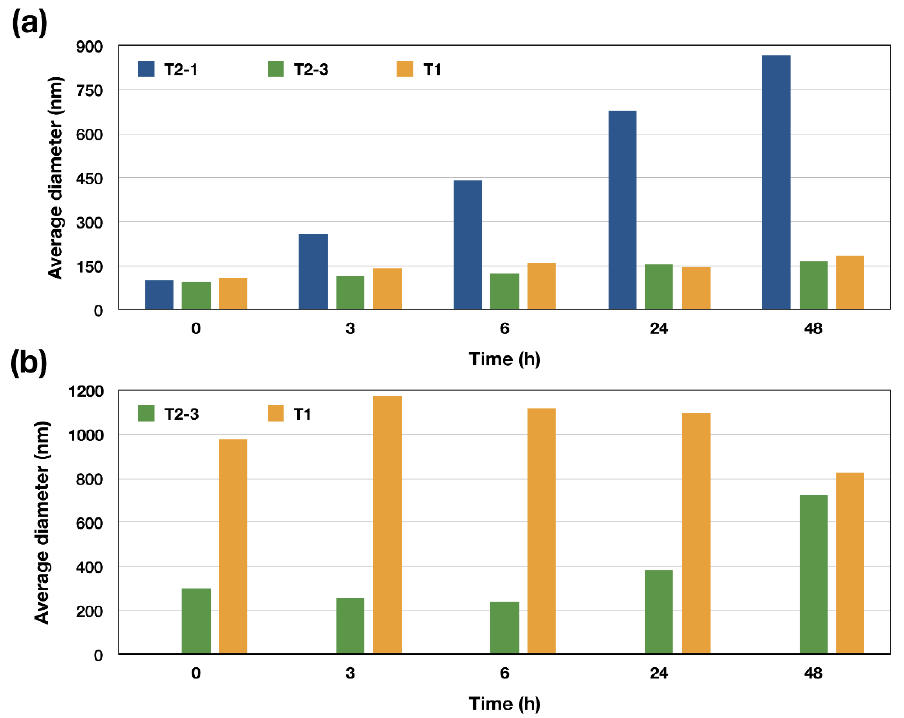
Figure 7. Stability of different triblock copolymer micelles assessed by DLS measurements in: ( a ) PBS buffer (pH 7.4); ( b ) FBS protein solution after various time intervals of incubation at 37 °C.